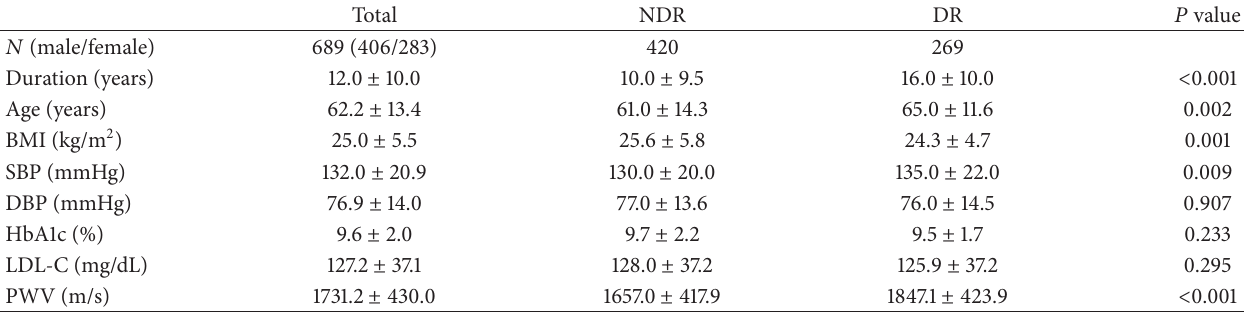
Table 1: Clinical characteristics of patients with type 2 diabetes mellitus.